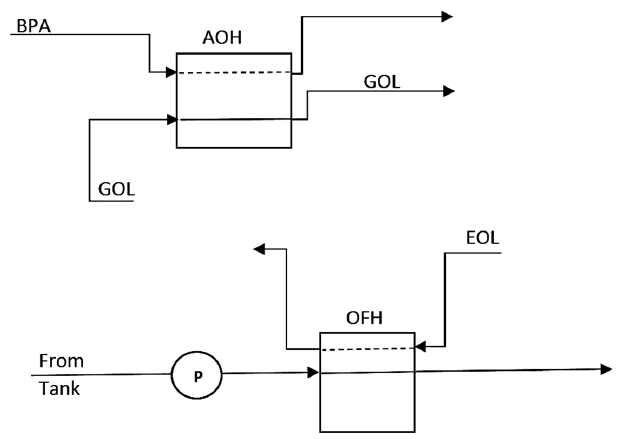
Figure 6. Thermal management system embodiments with separate line heat exchangers for geared systems.